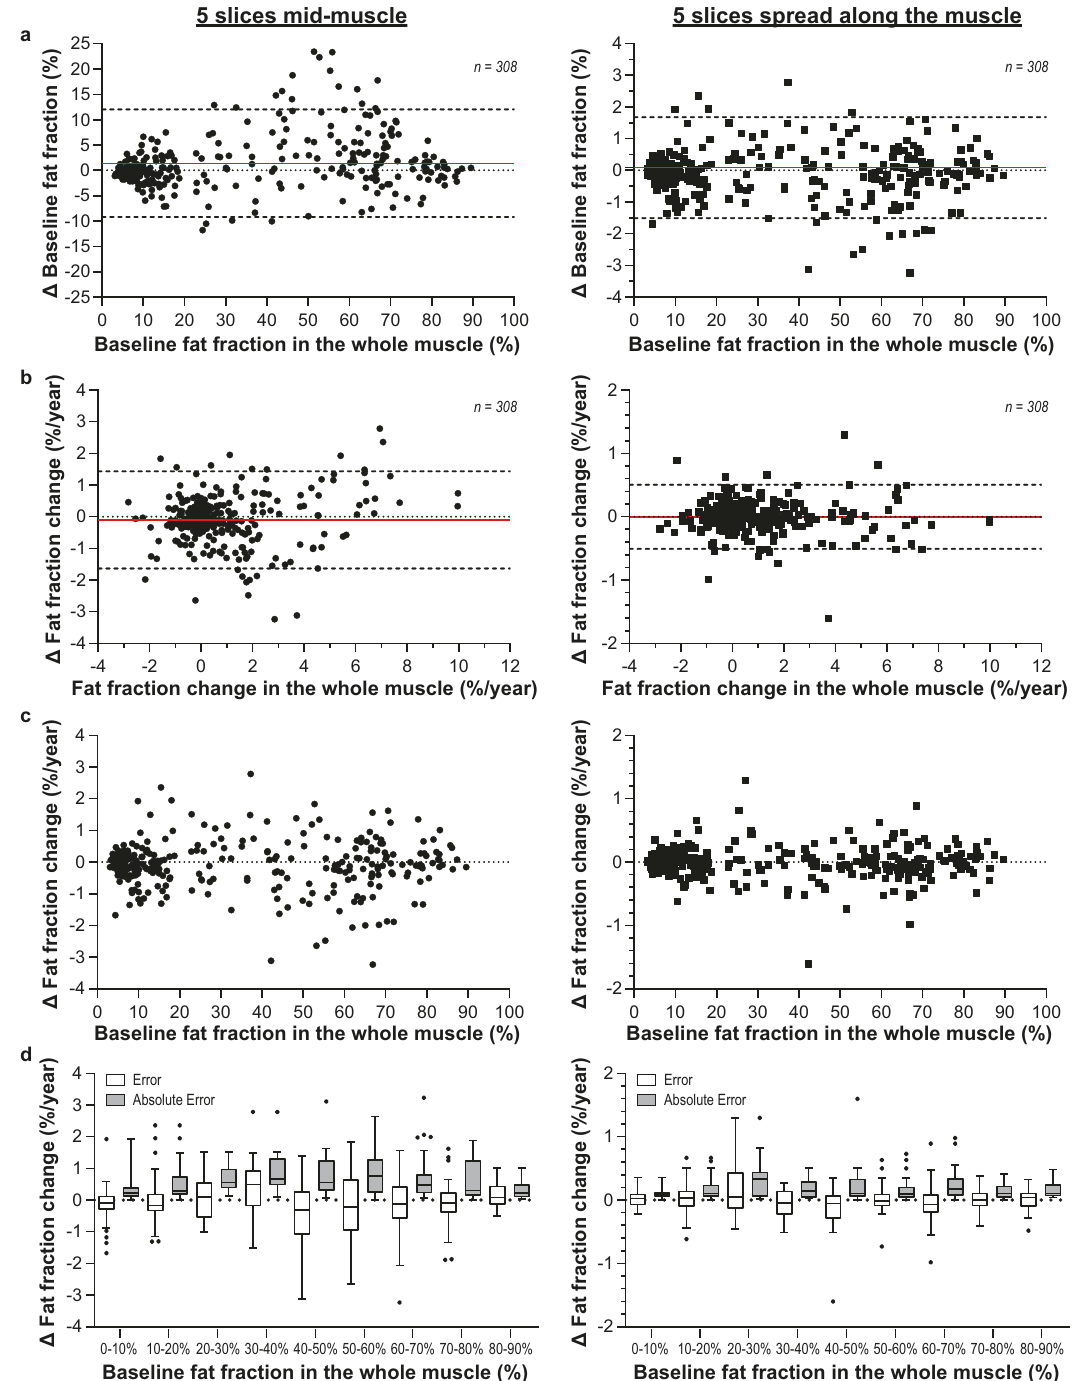
Fig. 7 Effect of localised sampling on the estimated fat fraction and its progression in muscles of facioscapulohumeral muscular dystrophy (FSHD) patients. a Bland – Altman graph displaying the error ( Δ ) in baseline fat fraction due to localised sampling of fi ve slices in the middle (left) and spread along the muscle length (right) against the baseline fat fraction of the whole muscle (error = fat fraction of fi ve slices – fat fraction of all slices). Each dot/square represents one muscle. Average error and limits of agreement are indicated by the red line and dashed lines, respectively. b Bland – Altman graph displaying the error in a change in fat fraction per year due to localised sampling of fi ve slices in the middle (left) and spread along the muscle length (right) against the change in fat fraction in the whole muscle (error = change fat fraction of fi ve slices – change fat fraction of all slices). c Error in change in fat fraction displayed against the baseline fat fraction of the whole muscle. d Tukey boxplots (showing median, interquartile range, and outliers) of the error (white) and absolute error (grey) for individual muscles, with the muscles grouped based on whole-muscle baseline fat fraction (10% increments). When analysing only the fi ve central slices (left), the error (grey bars) shows that the change in fat fraction is generally overestimated in muscles with a baseline fat fraction of 20 – 40% and underestimated in muscles with a baseline fat fraction of 40 – 60%. The white bars show that in intermediately fat-in fi ltrated muscles (10 – 60% baseline fat fraction), the absolute error was about 0.8%/year. This absolute error is signi fi cantly reduced when the fi ve slices are spread along the muscle length (right), to only 0.2%/year. n is the number of analysed